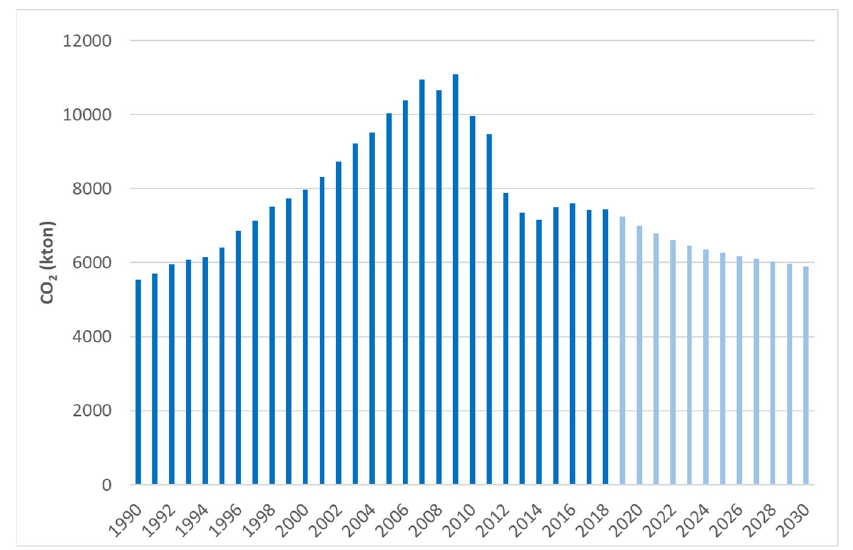
Figure 16. Total NMVOC (Non-methane volatile organic compounds) emissions from passenger cars in Greece for the period 1990–2030.